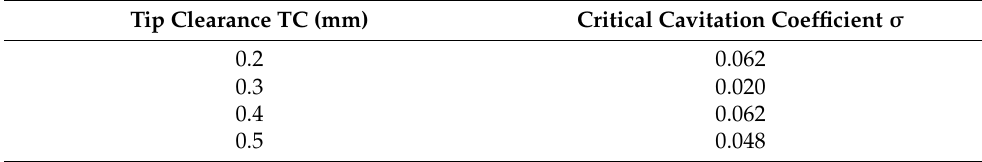
Table 2. Critical cavitation coefficient values under different TCs.